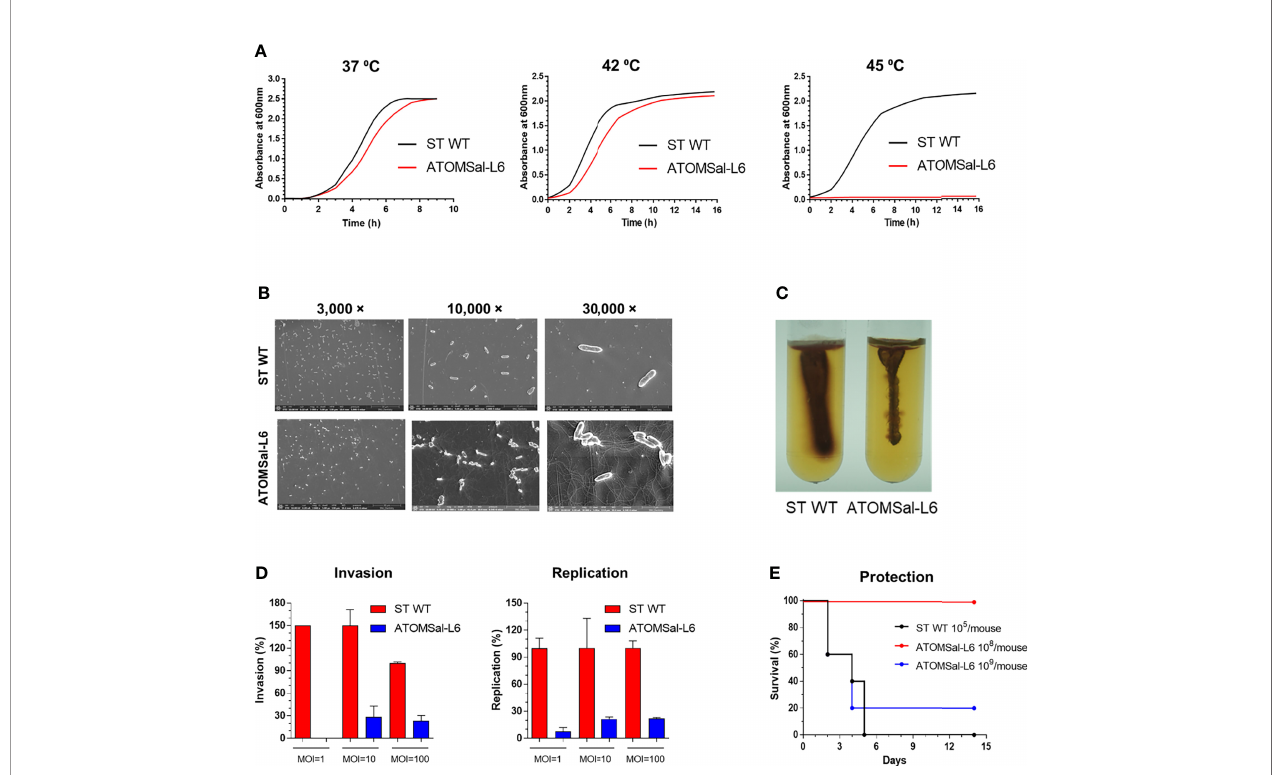
FIGURE 2 | Analysis of biochemical and genetic characteristics of ATOMSal-L6. (A) Growth curve of ST WT and ATOMSal-L6 at 37°C, 42°C, and 45°C. (B) Morphology analysis of ST WT and ATOMSal-L6 using scanning electron microscopy (SEM; left panel). (C) Salmonella motility assay for ST WT and ATOMSal-L6 on LB containing 0.4% agar and 1% triphenyltetrazolium chloride at 37°C for 3 days. One Salmonella colony on LB agar plate was stabbed once to a depth of ~2 cm in the middle of the motility agar tube (right panel). (D) In vitro virulence test. Macrophages (RAW 264.7 cells) were infected with ST WT or selected candidates at MOI = 1, 10, 100, and bacterial viability was evaluated at 2 h (invasion; left panel) or 18 h (replication; right panel). Relative invasion and replication fold of candidates were calculated by comparing with ST WT. Data are representative of three independent experiments and are presented as the mean ± standard deviation. (E) In vivo virulence of ATOMSal-L6. C57BL/6 mice (n=5) were infected i.p. with ST WT (10 5 CFU) or ATOMSal-L6 strain (10 8 , 10 9 CFU) and survival was monitored for 14